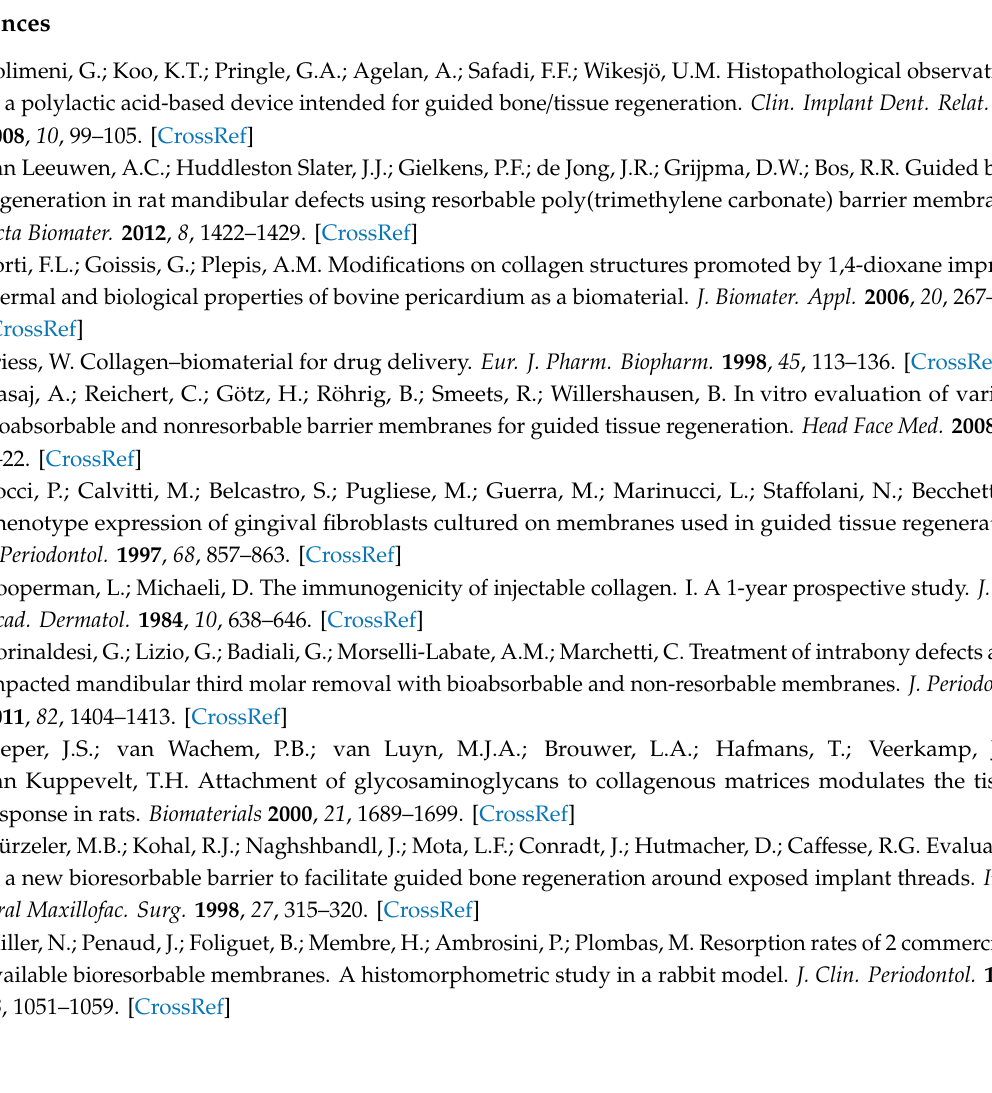
Table S1: Semiquantitative evaluation seven days post-implantation. The collected data from the semiquantitative analysis were used to evaluate the tissue reaction and biocompatibility, as suggested in ISO 10993-6. The values for each animal are a median of 10 sections evaluated per animal. Table S2: Semiquantitative evaluation 21 days post-implantation. The collected data from the semiquantitative analysis were used to evaluate the tissue reaction and biocompatibility, as suggested in ISO 10993-6. The values for each animal are a median of 10 sections evaluated per animal. Table S3: Semiquantitative evaluation 63 days post-implantation. The collected data from the semiquantitative analysis were used to evaluate the tissue reaction and biocompatibility, as suggested in ISO 10993-6. The values for each animal are a median of 10 sections evaluated per